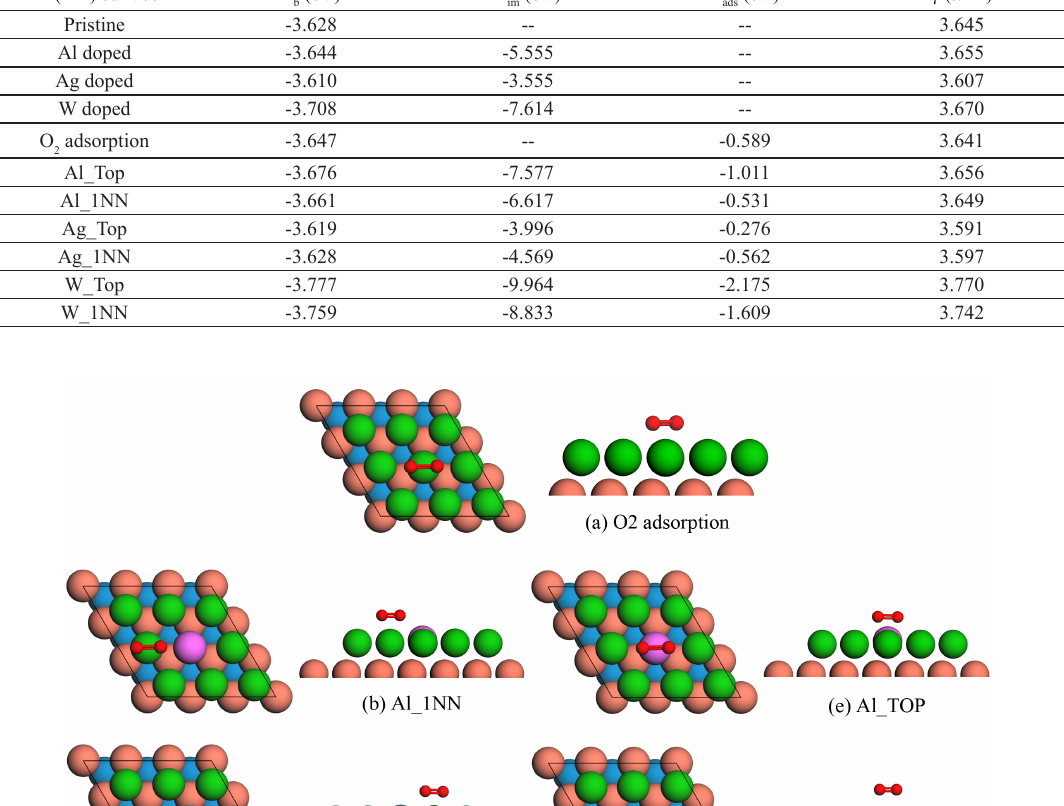
), binding energy ( E im